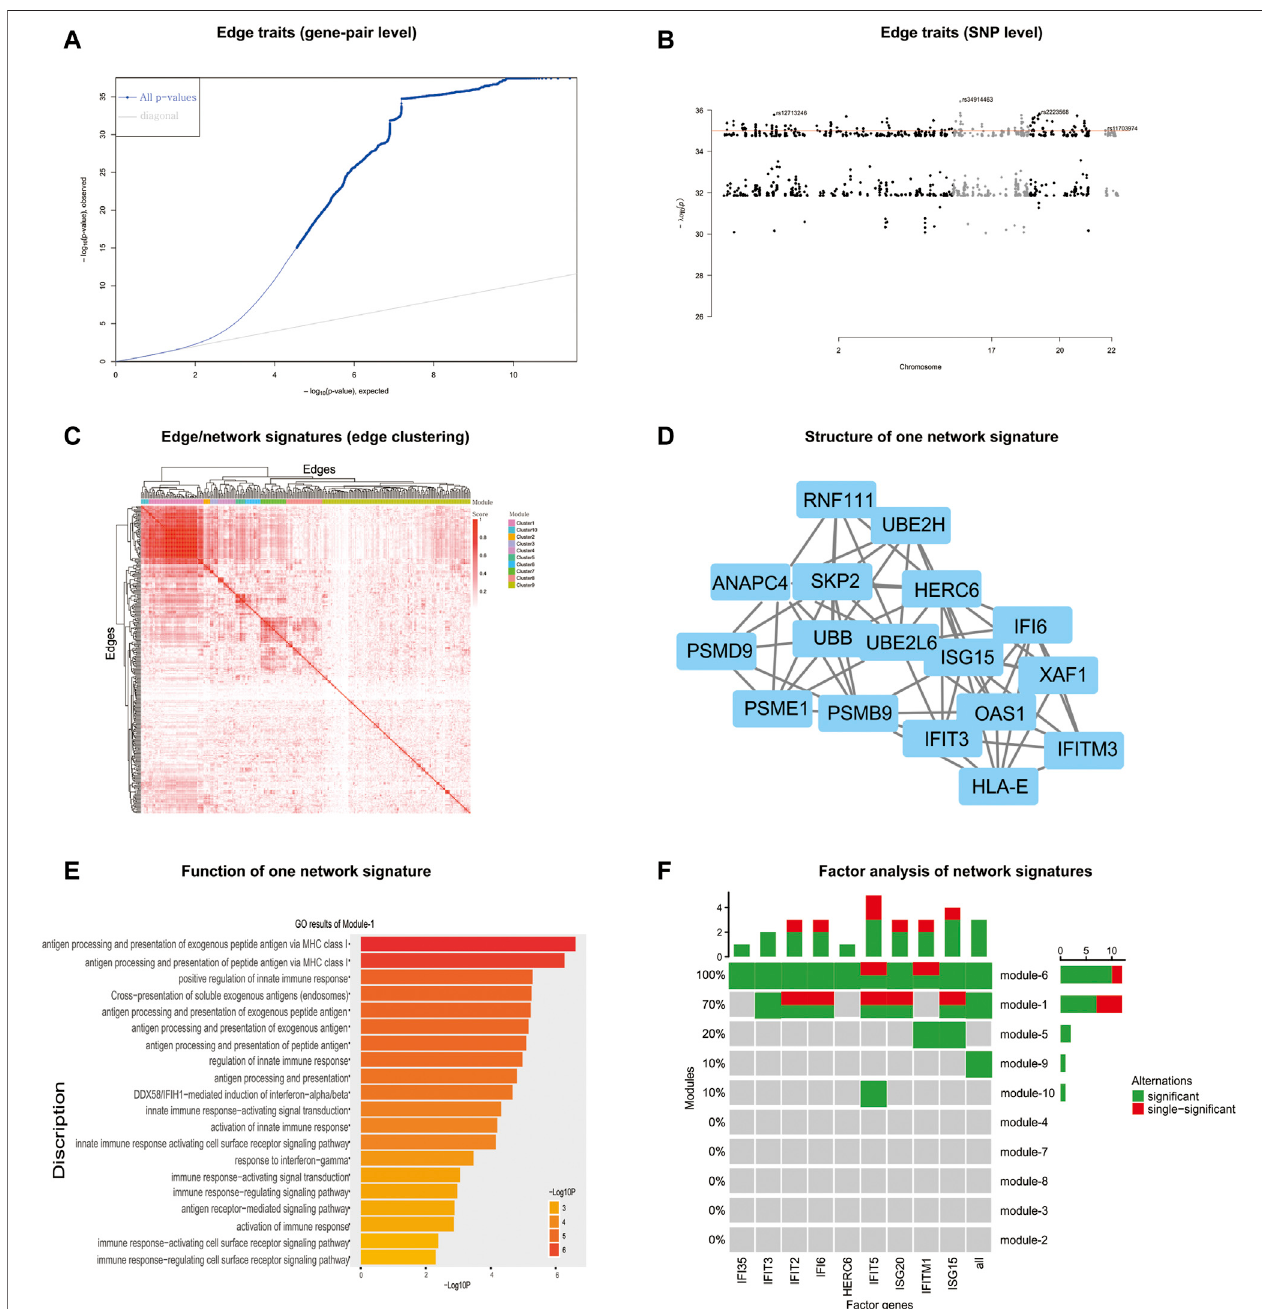
FIGURE5| nQTL analysis results from thehuman PBMC dataset. (A) QQ-plotofedge trait on the genelevel. (B) Manhattan plot ofedge trait on theSNP level. (C) Network signature from edge/gene-pair clustering. (D) The network structure ofone network signature. (E) GO analysis ofone signi fi cant network signature. (F) CCA of network signatures and immune factors or in fl ammatory